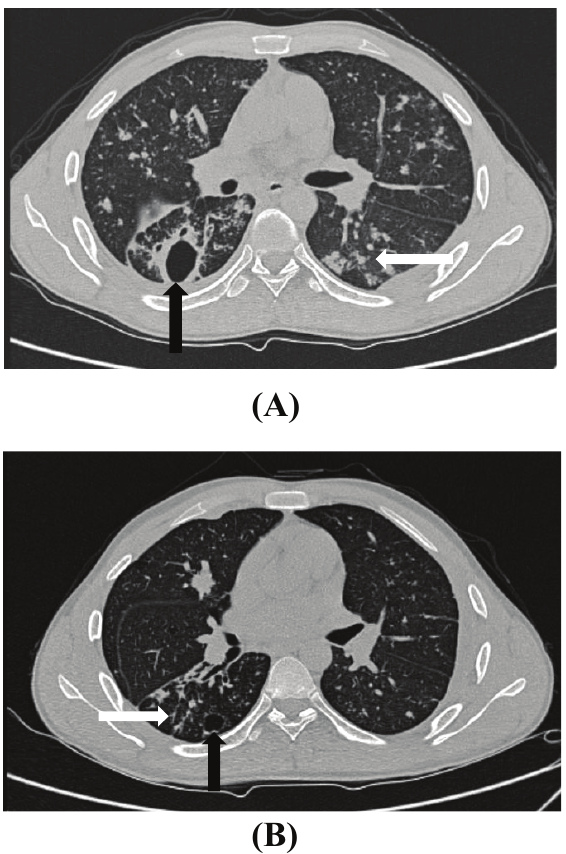
Figure 3 : Axial section of HRCT lung in case of tuberculosis at subcarinal level. (A) HRCT scan acquired before starting the treatment showed multiple nodules (white arrow) in both lungs with a thick-walled cavity (black arrow) in superior segment of right lower lobe. (B) Follow-up scan after anti-tuberculous treatment shows marked thinning of the cavity wall (black arrow) with significant reduction in nodule burden. Note is also made of fibrotic changes (white